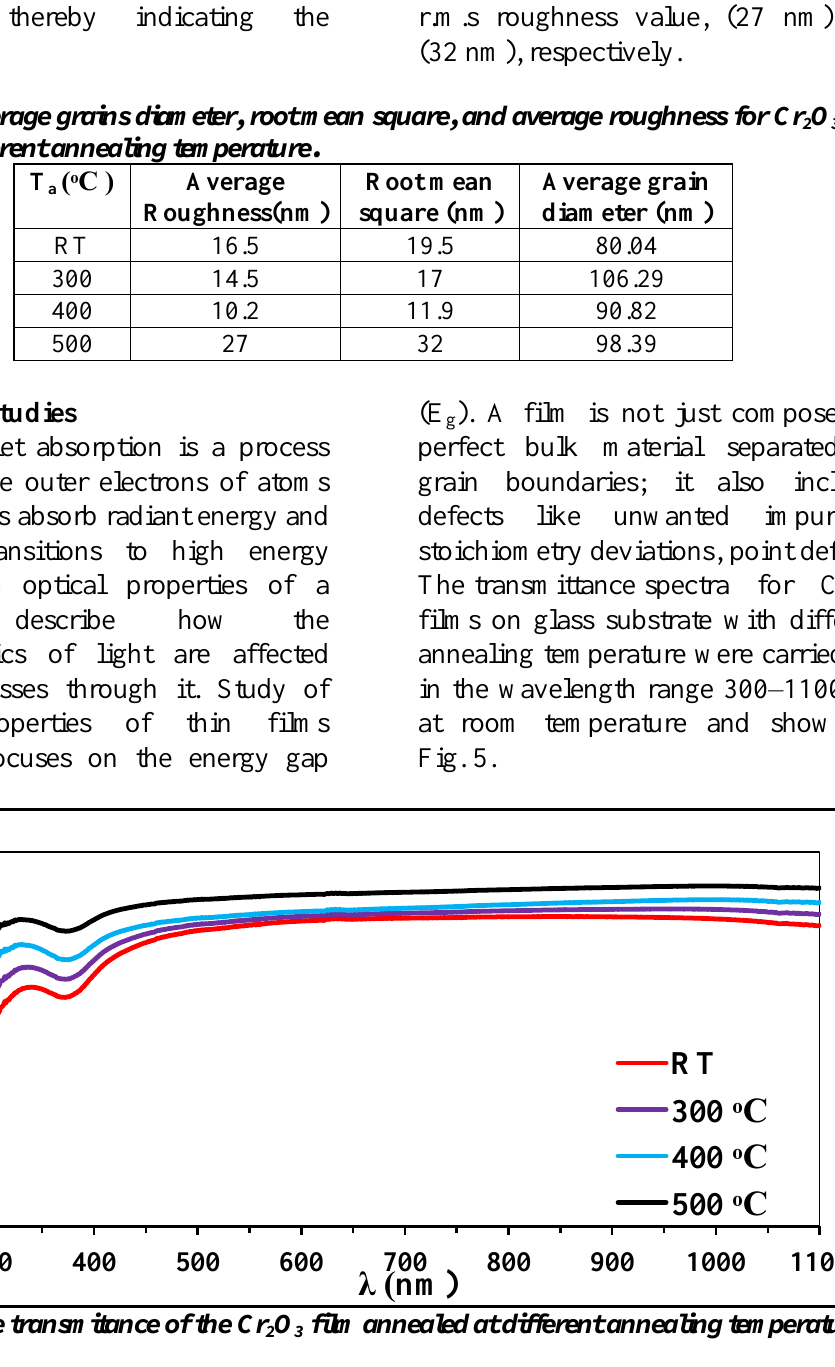
O film annealed at different annealing 2 3